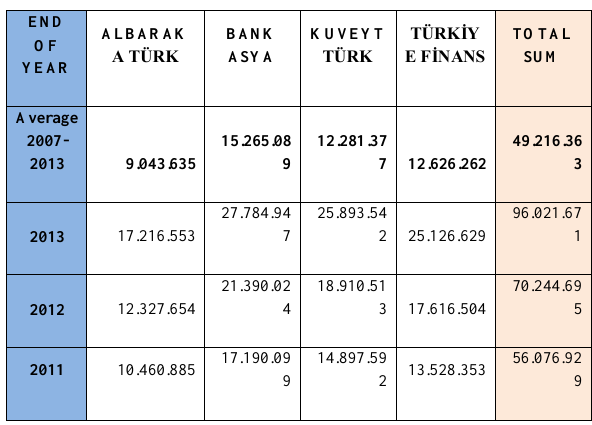
Table-16/a: Growth of Total Assets in Participation Banks, 2007- 2013 (1000TL)